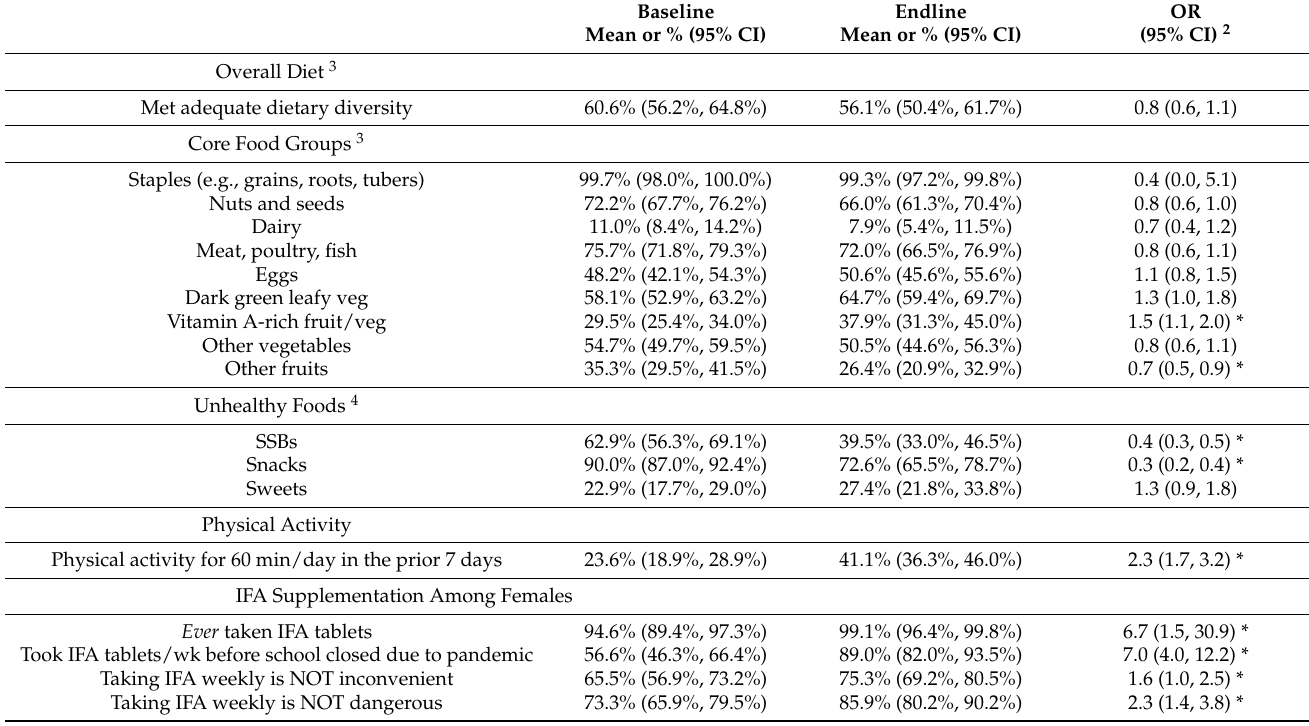
Table 3. Diet and physical activity behaviors among adolescents 1